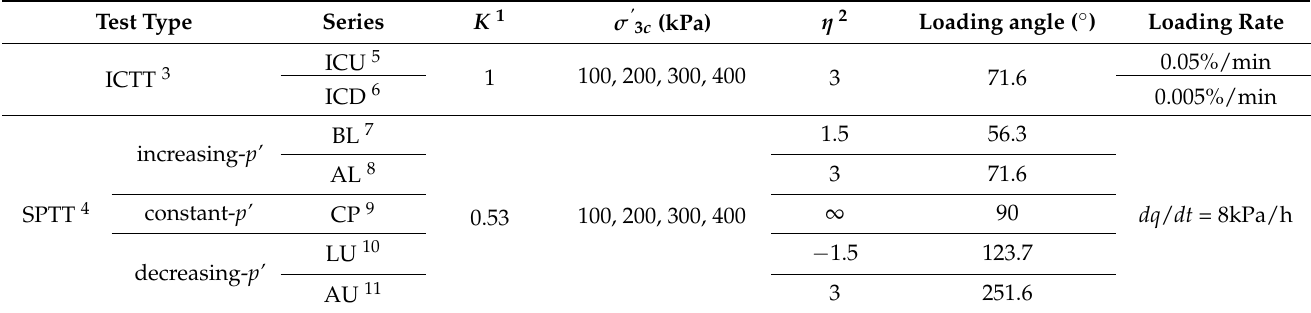
Table 3. Summary of triaxial tests.